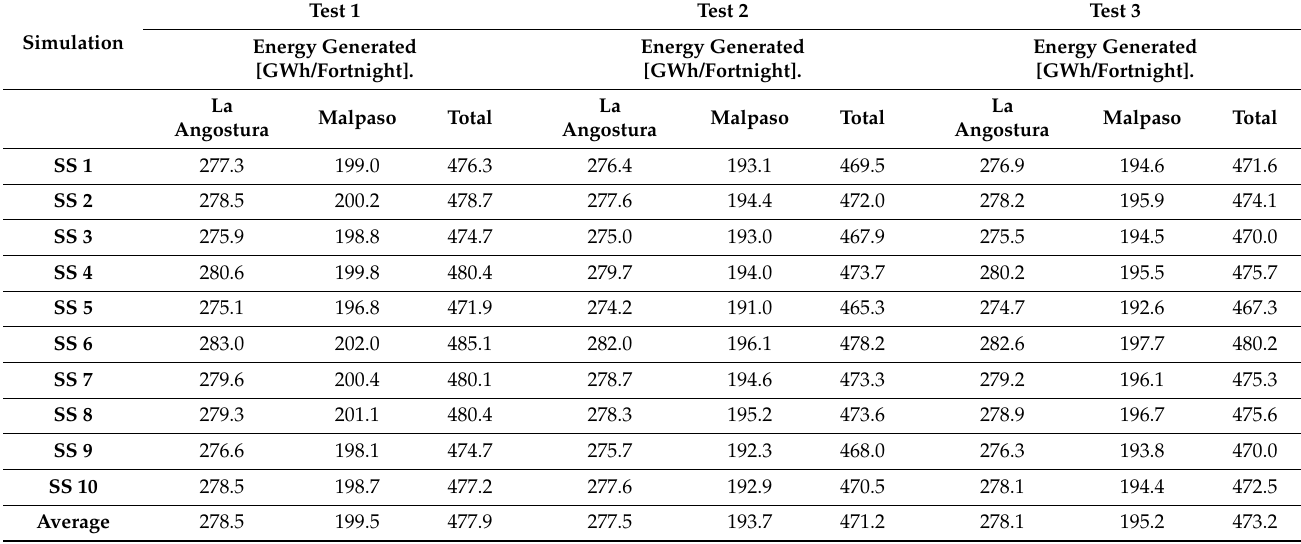
Table 5. Summary of the joint simulation of La Angostura and Malpaso dams. Energy generated per fortnight.